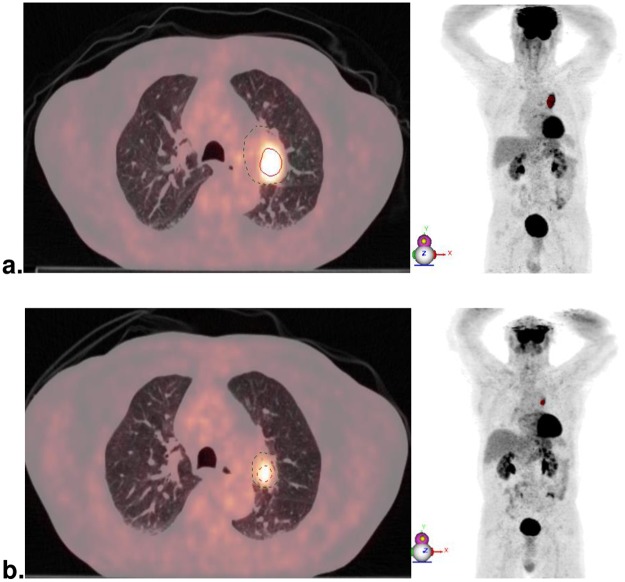
Tumoral response.66-year-old patient with T2N2 (Stage IIIA) left upper lobe squamous cell carcinoma. At baseline (a), tumor SUVmax was 12 g/ml, MTV 13 cc and TLG 89 g. After 2 cycles of carboplatin-paclitaxel (b), SUVmax was 8.2 g/ml (ΔSUVmax = -33%), MTV 2.4 cc (ΔMTV = -82%) and TLG 11.3 g (ΔTLG = -87%). After 45 months, the patient was still alive and showed no sign of recurrence.